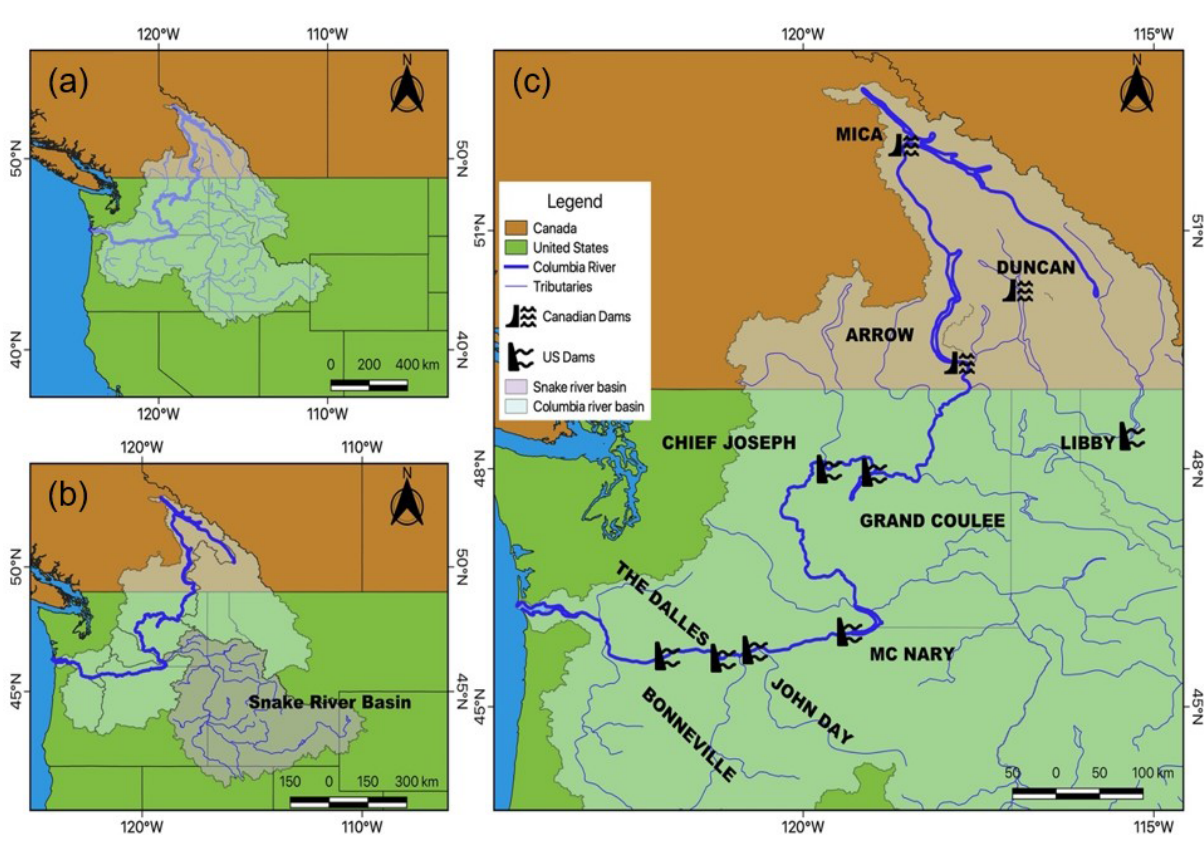
Figure 1. Map showing (a) the Columbia River basin across Canada and the United States, (b) the Snake River basin and its tributaries within the Columbia River basin, and (c) location of treaty dams along Canada and the United States which are also included in the socio- hydrological system dynamics